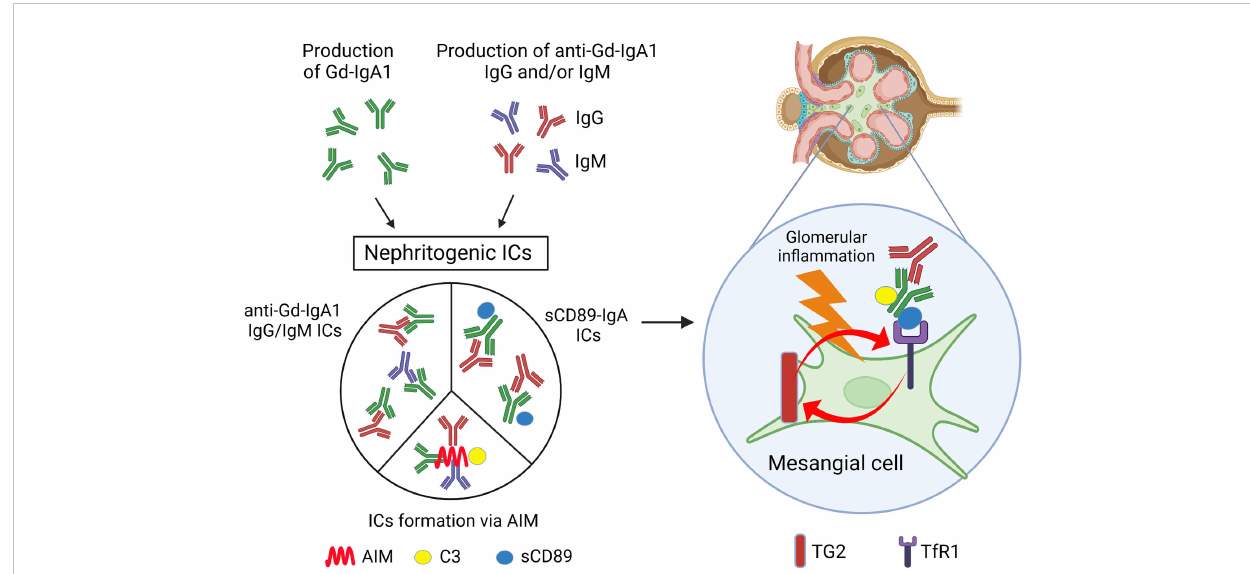
FIGURE 1 Scheme of the possible mechanism for glomerular in fl ammation in IgAN. Patients with IgAN show increased levels of serum Gd-IgA1 and anti-Gd- IgA1 IgG and/or IgM Abs. Nephritogenic ICs including these Abs, generated by various mechanisms as depicted, deposit mesangial region in glomeruli and induce mesangial in fl ammation. Gd-IgA1, galactose-de fi cient IgA1; ICs, immune complexes; AIM, apoptosis inhibitor of macrophages; sCD89, soluble fragment of CD89; C3, complement C3; TG2, transglutaminase 2; TfR1, transferrin receptor 1. Created with